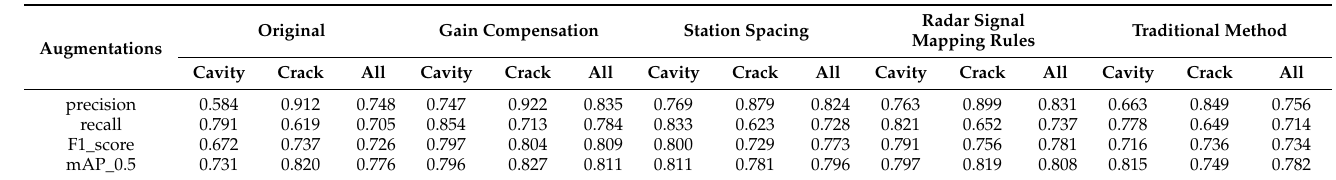
Table 5. The performance of model comparison using different augmented data for